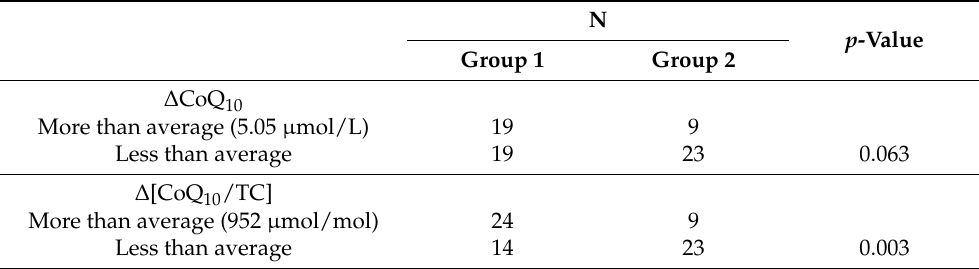
Table 4. Associations between group 1 and group 2 with HR/LR classification in